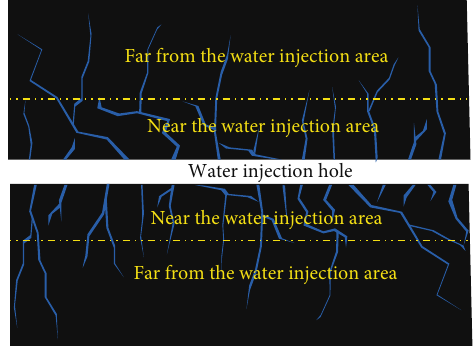
Figure 2: Simpli fi ed model of coal seam water